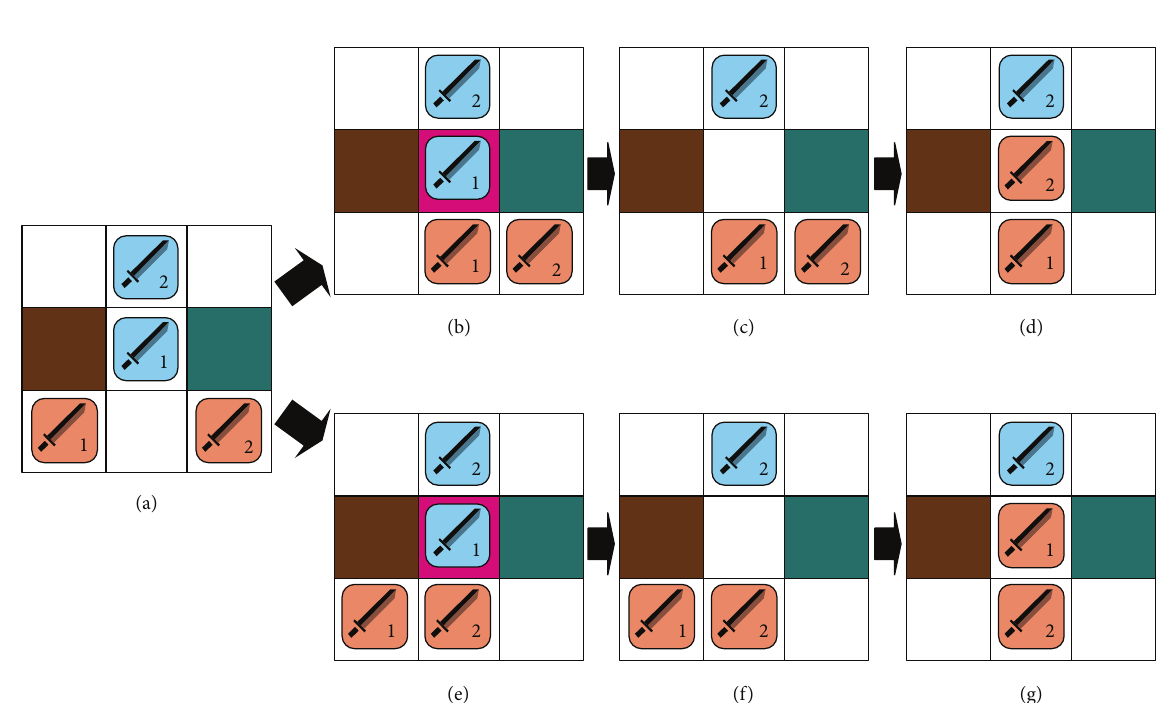
Figure7: Effect ofactions sequence. (a)Theinitial stateofred side’s turn.(b–d)Redswordsmannumber 1actsand eliminates blueswordsman number 1, followed by red swordsman number 2. (e–g) Red swordsman number 2 acts and eliminates blue swordsman number 1, followed by red swordsman number